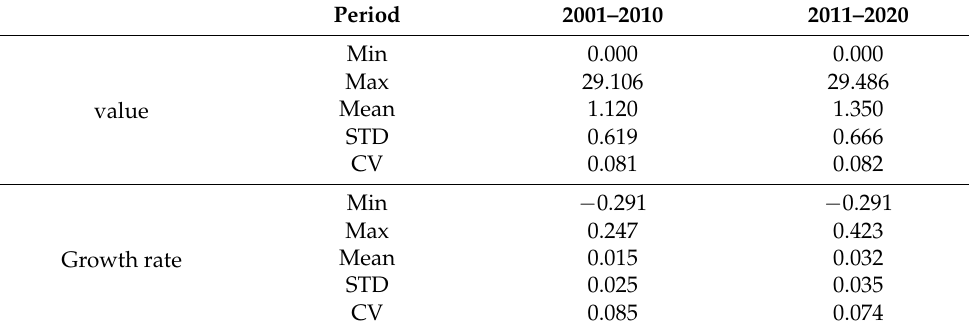
Table 3. Statistical table of WUE value and growth rate in Loess